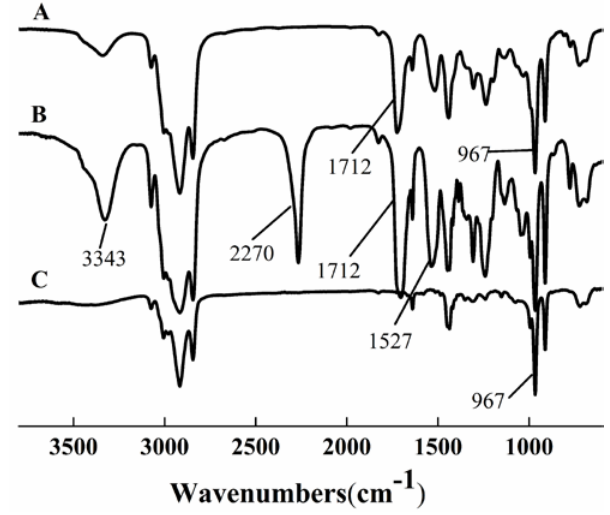
Figure 1. FT-IR spectra of HTPU ( A ), prepolymer ( B ), and HTPB ( C ).